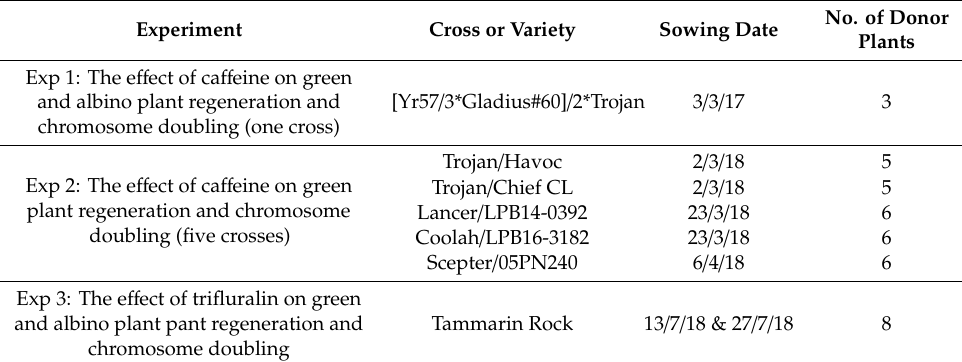
Table 6. Spring wheat crosses / varieties used in this